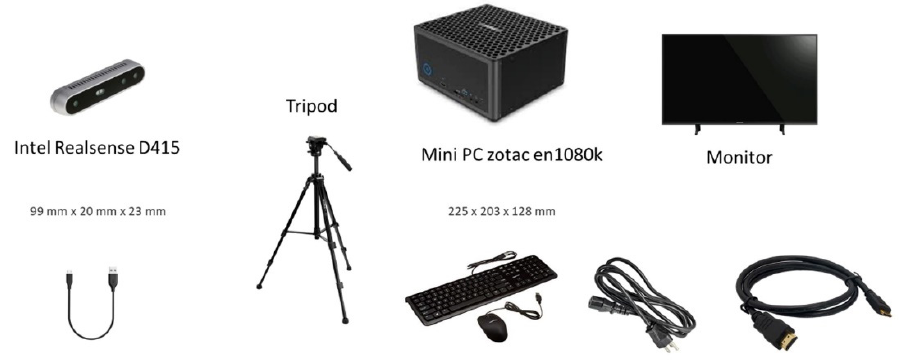
Figure 4. Experimental setup for home installation.